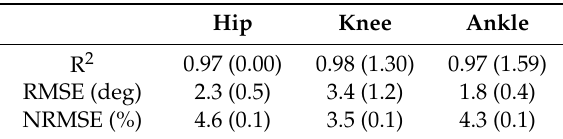
Table 2. Average error and accuracy of estimated angles (SD) in intra-participant models among 10 participants. RMSE, root mean squared error; NRMSE, normalized root mean squared error.